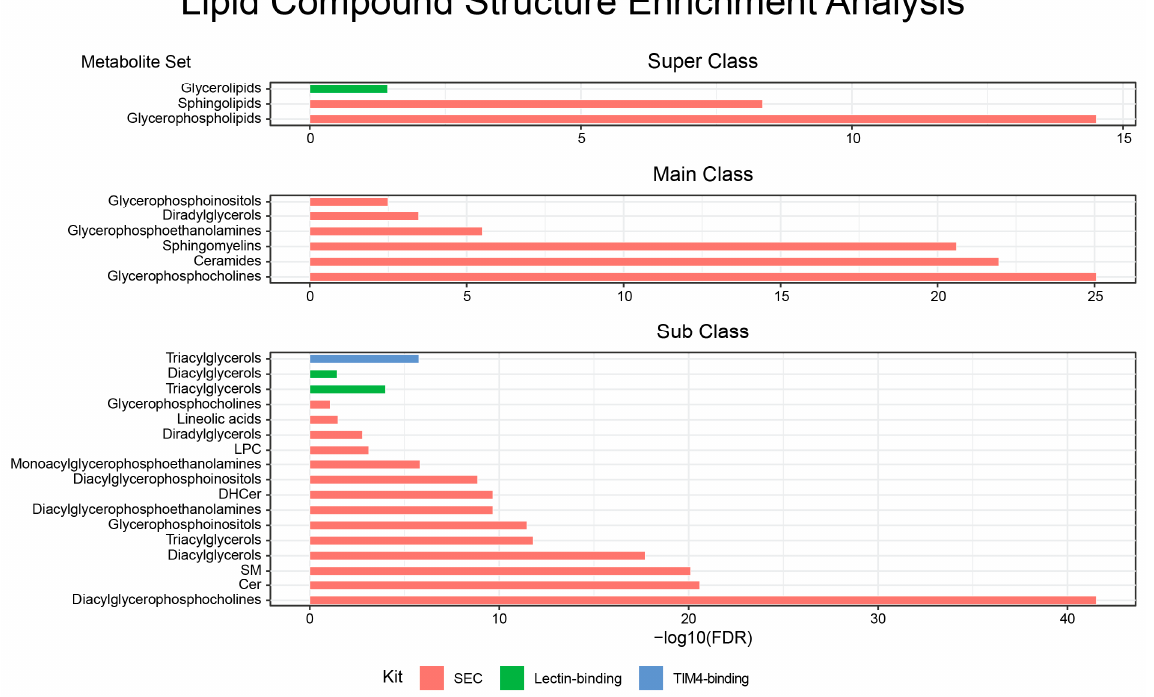
Figure 4. Enrichment of compound classes for each exosome isolation method using unique lipids. Results shown are FDR < 0.1.